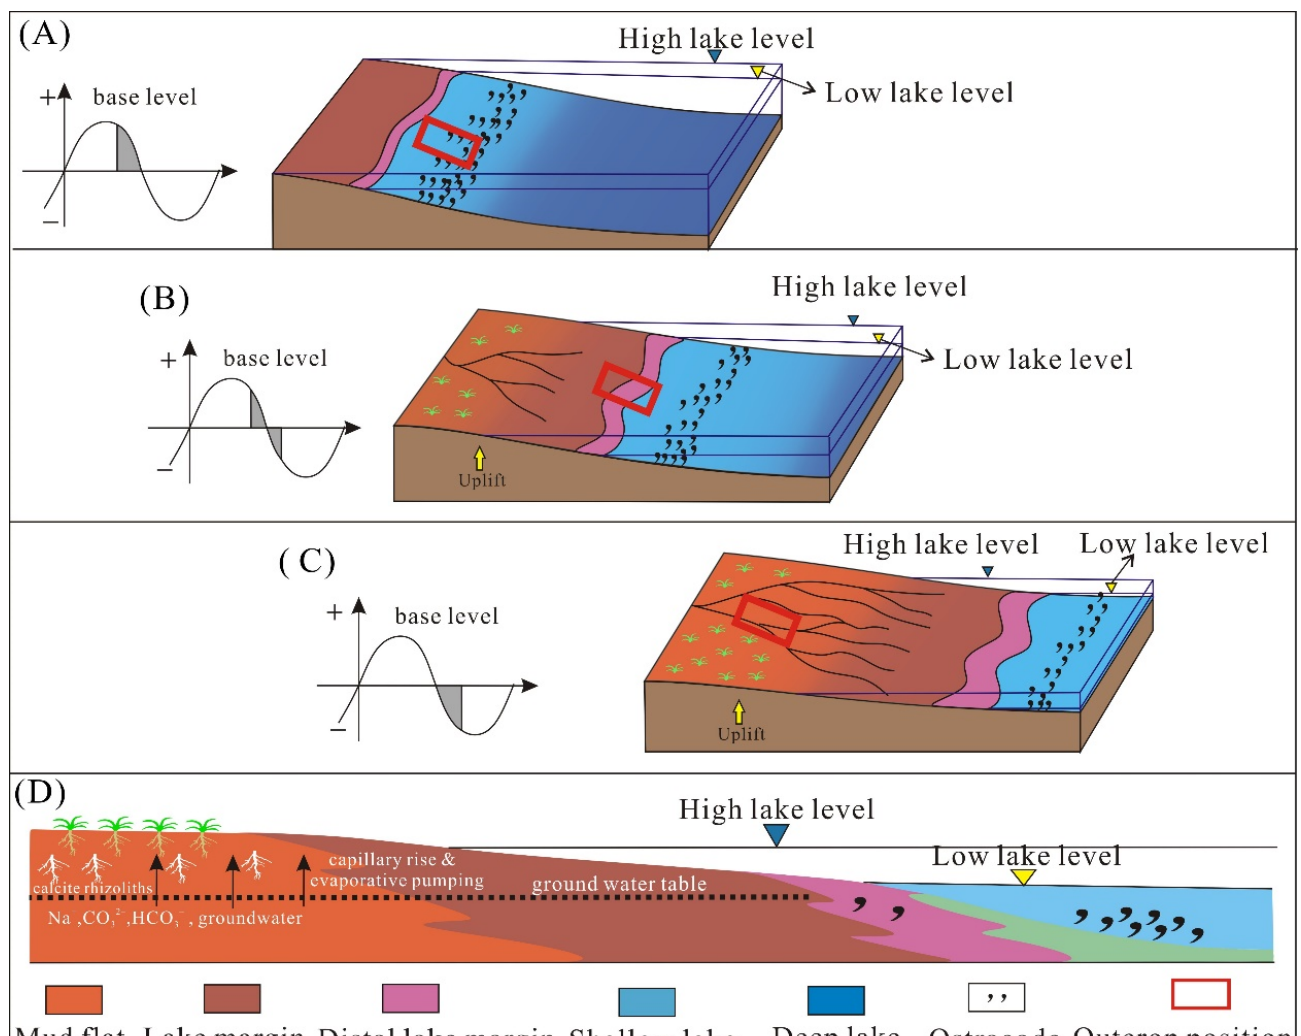
Figure 8. Conceptual sedimentary model showing the depositional environment variation and paleosol formation condition. ( A ) Shallow lake environments interpreted from the lower part of the field outcrop. ( B ) Shallow margin environments interpreted from the low part of the field outcrop. ( C ) Mudflat environments interpreted from the upper part of the field outcrop. ( D ) Sedimentary model showing the depositional environment and distribution of paleosols in the Yaojia Formation.